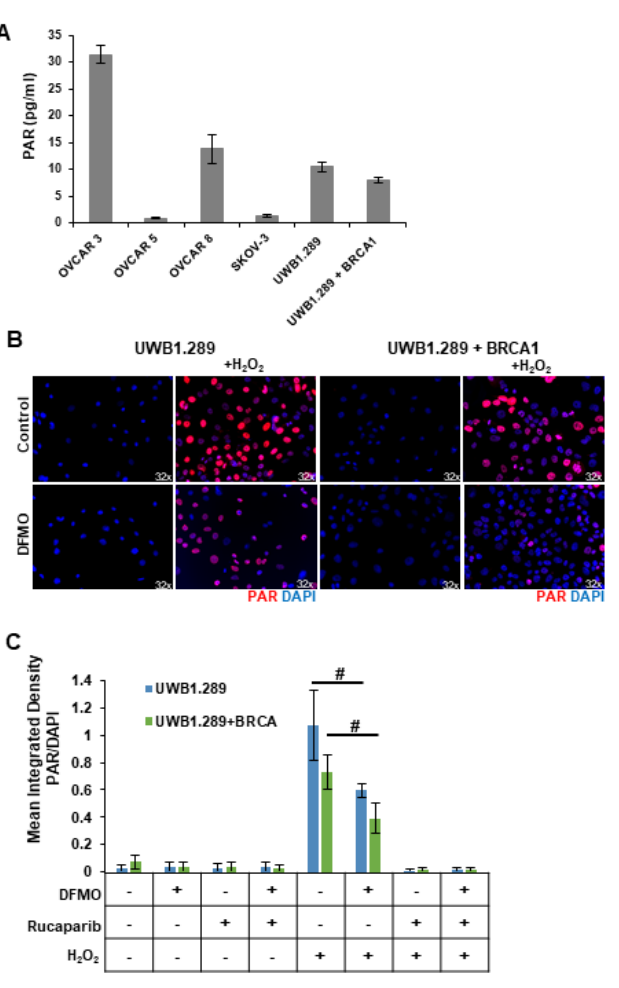
Figure 2. DFMO treatment reduces H 2 O 2 -induced PARylation in ovarian tumor cell lines. ( A ) Basal levels of poly (ADP-ribose) (PAR) were measured in OVCAR3, OVCAR5, OVCAR8, SKOV3, UWB1.289, and UWB1.289+BRCA after 72 h in culture. ( B ) UWB1.289 and UWB1.289+BRCA cells were pre-